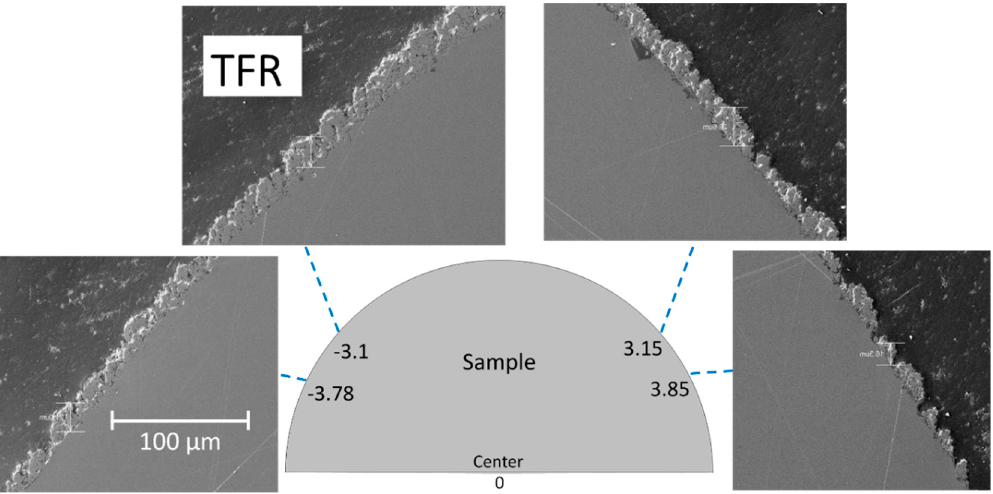
Figure 15. Cross-section images showing the columns on the rod sample with fine grit blasting (TFR).